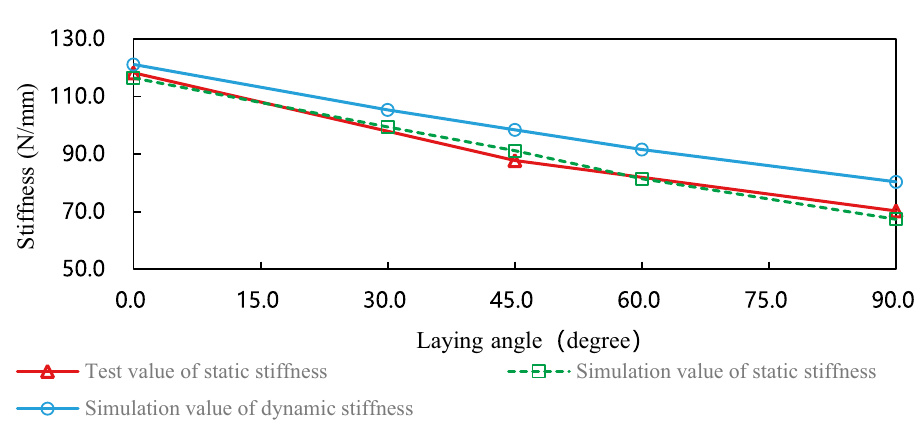
Figure 5. The simulation and experimental curves of leaf spring with different laying